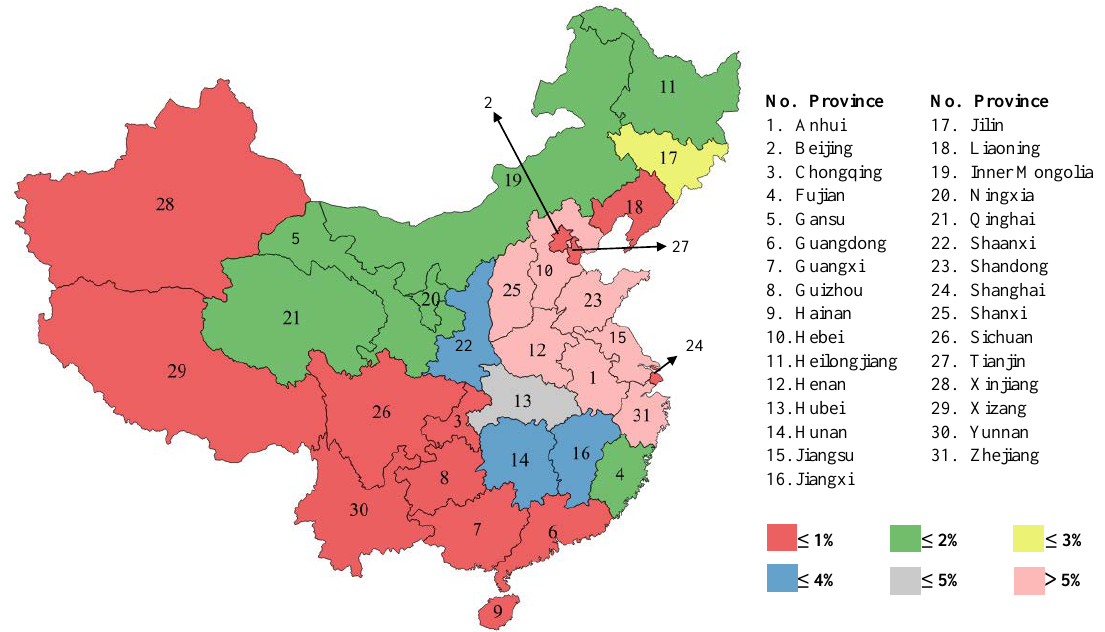
Figure 11. Proportion of newly installed capacity for photovoltaic power generation by region in mainland China in 2017.